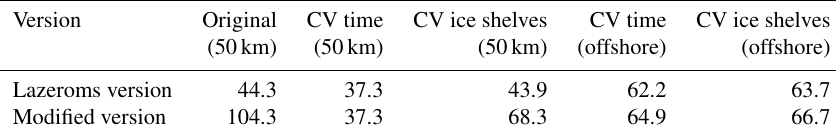
Table 5. Root-mean-squared error (RMSE int ) between the reference (NEMO) and parameterised (plume parameterisation) yearly integrated ice-shelf melt [Gtyr − 1 ] over the 35 individual ice shelves and 127 simulation years using the original parameters (Lazeroms et al., 2019). RMSE int over the synthetically independent evaluation dataset resulting from the cross-validation (CV) over time and the cross-validation over ice shelves. It is given for the Lazeroms formulation (Lazeroms et al., 2019) and the modified version.